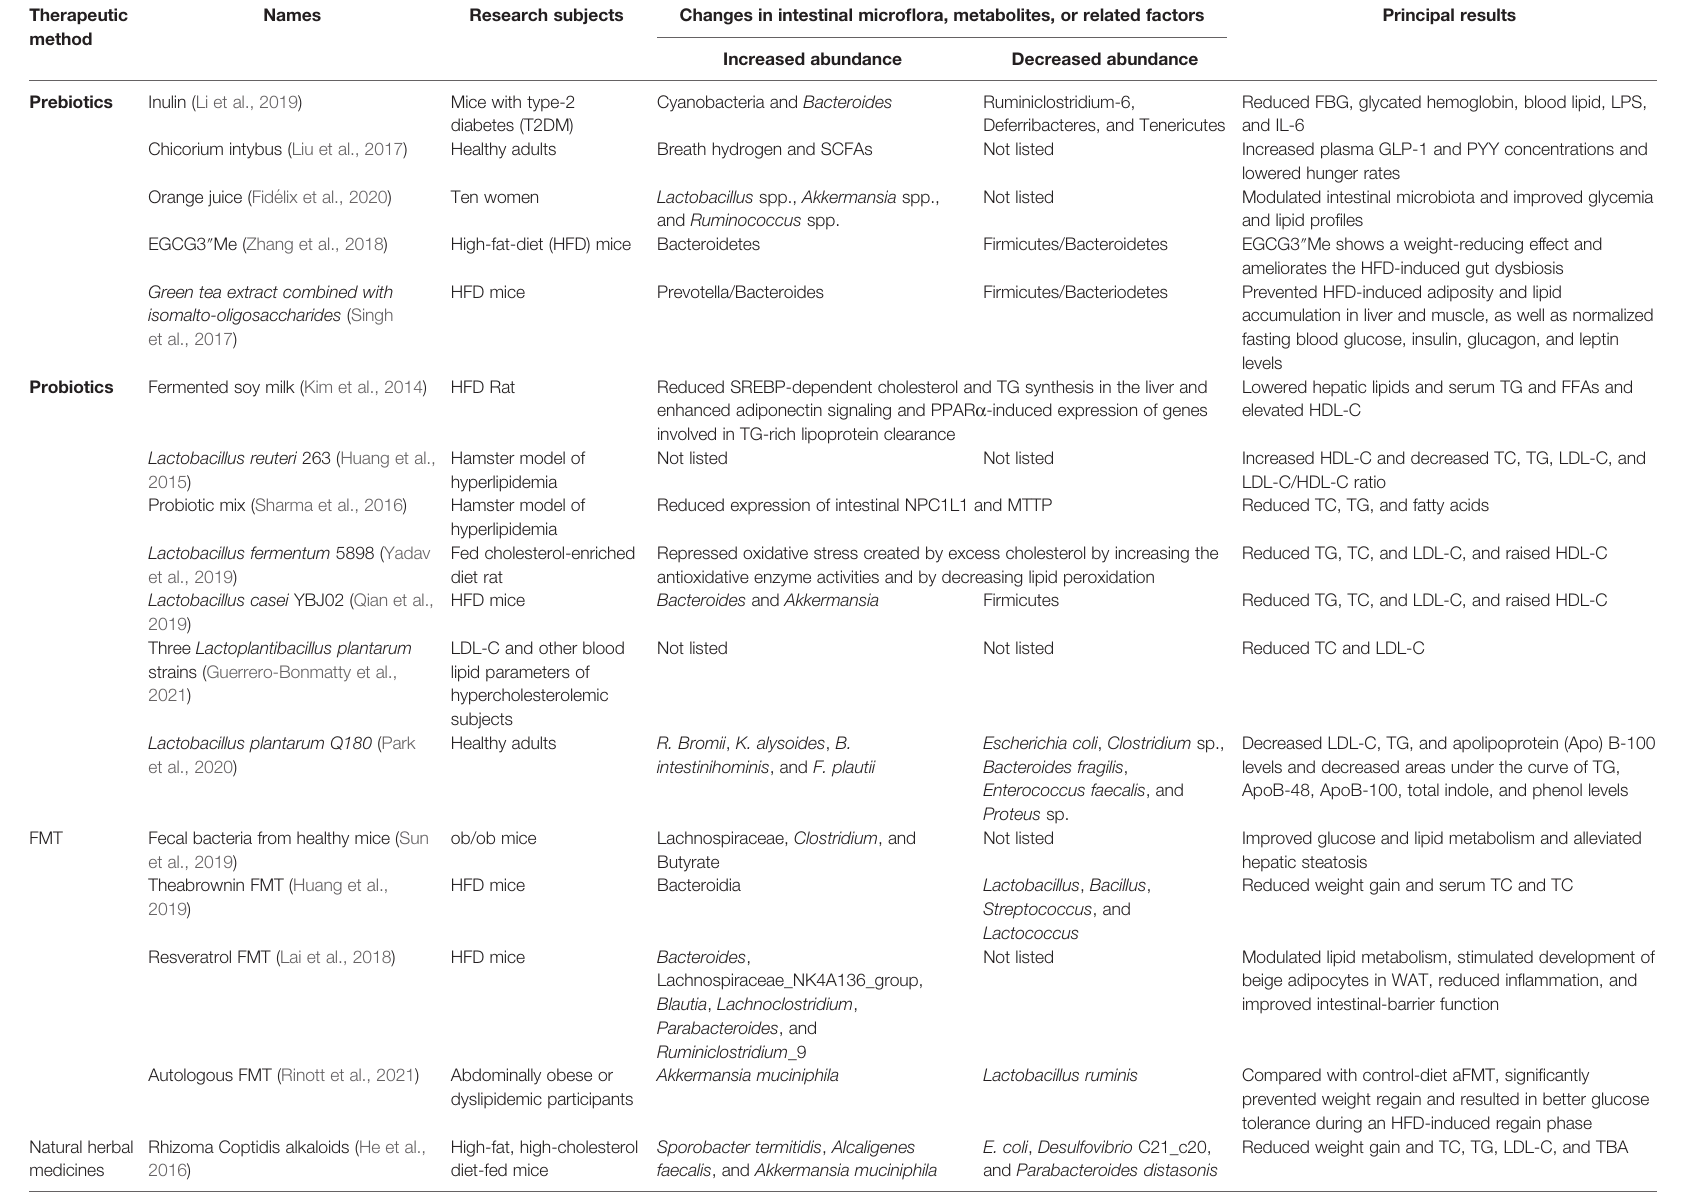
TABLE 1 | Treatment of hyperlipidemia targeted at gut microbiota. Therapeutic